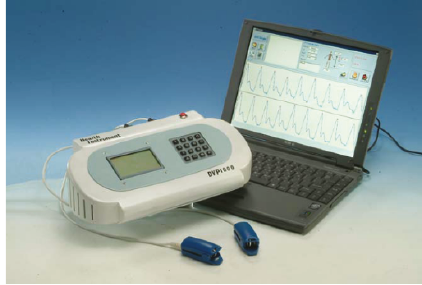
Figure 7: Development model for multichannel DTMF signal de- tection.